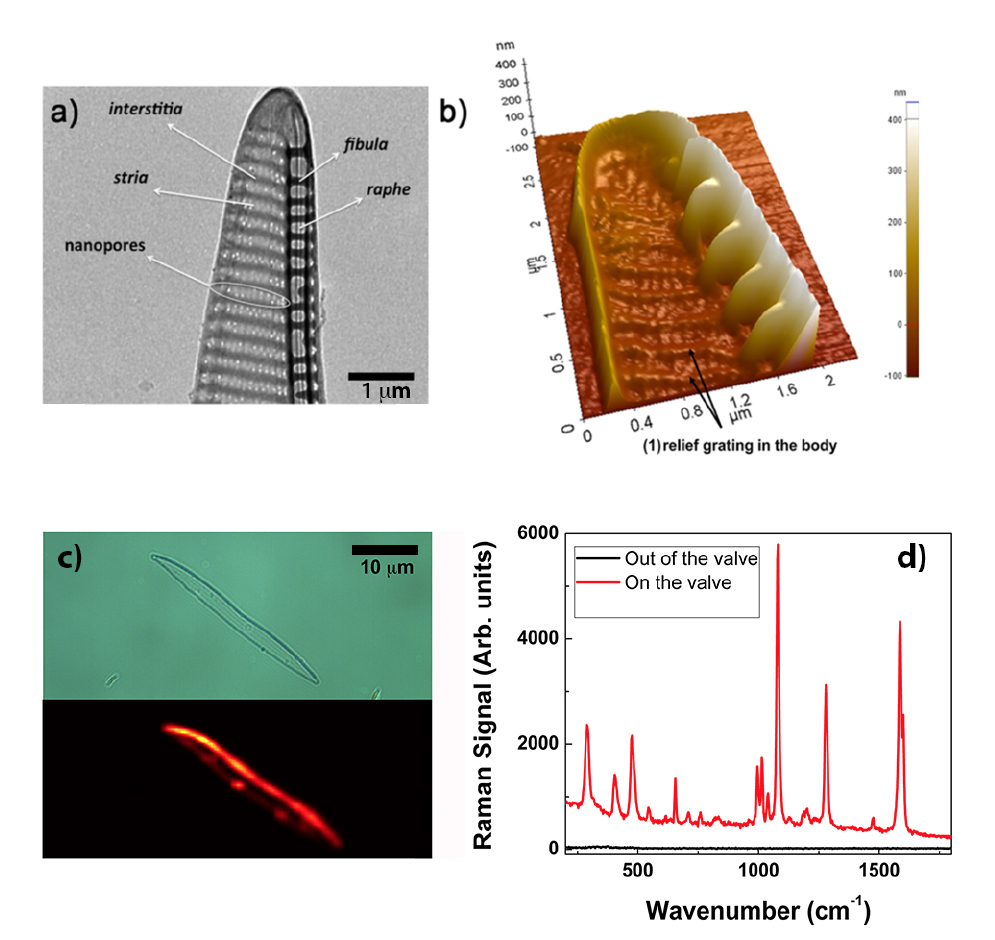
Figure 6. ( a ) Transmission Electron Microscopy (TEM) image showing the details of a P. multistriata valve with indications of its characteristic features. Several periodic subpatterns, whose overall interaction provides an efficient coupling with incident optical radiation, can be identified. ( b ) Atomic Force Microscopy (AFM) scan of a metalized valve showing its 3D morphology, in particular the extruded edge wall with its peculiar blade profile. ( c ) Optical image and relative Raman map of a single metalized valve covered with a biphenyl-4-thiol (BPT) monolayer used to estimate the EF. Most of the signal comes from the lateral, extruded edge. Gold thickness: 40 nm. ( d ) BPT average spectra outside (black) and on (red) the metalized valve after excitation at 785 nm. ( a , b ) reproduced with permission from Ref. [80]. Copyright 2018 American Chemical